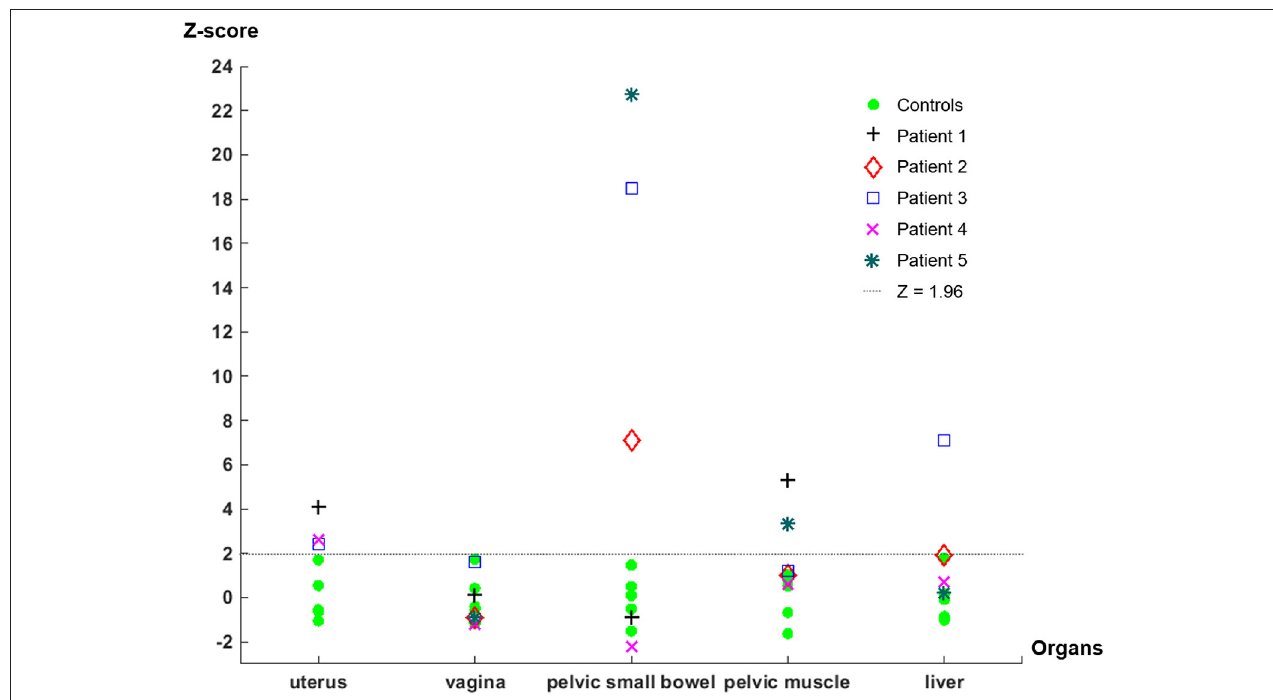
FIGURE 1 | Z -scores derived from the SUV max of each organ of control and patient subjects. Note that the uterus measurements of Patient 2 and Patient 5 are not available because the PET/MRI study was performed after they received hysterectomy. The liver uptake measurement of Patient 1 was not available because the liver was out of the FOV when the pelvic PET/MRI scan was